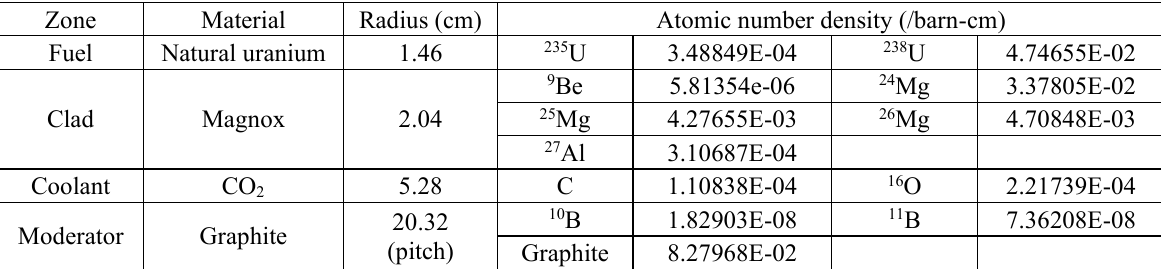
Table II. Specification of geometry and composition.